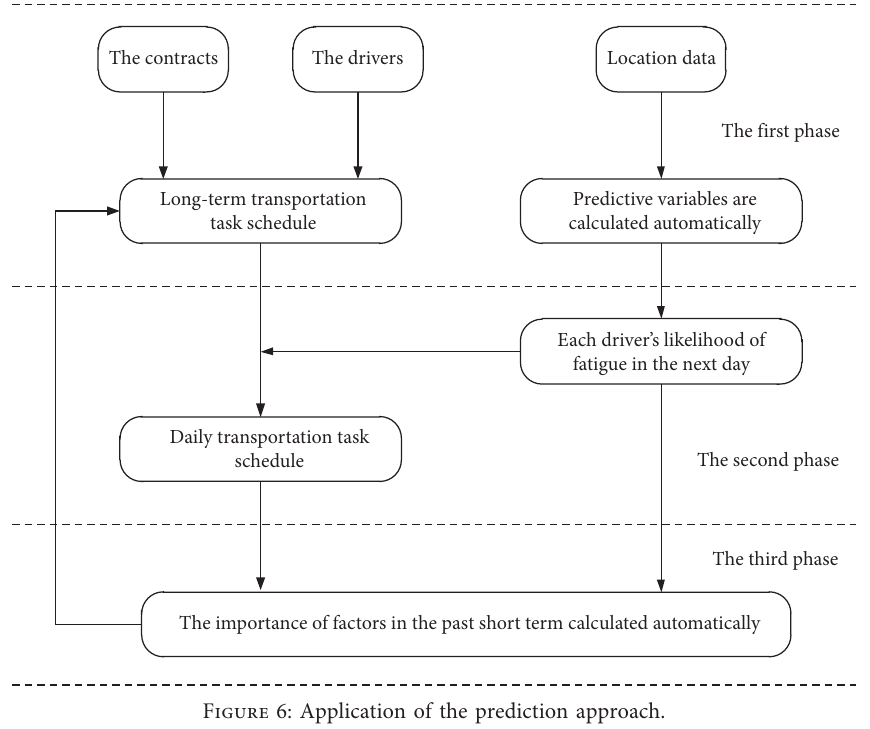
Figure 6: Application of the prediction